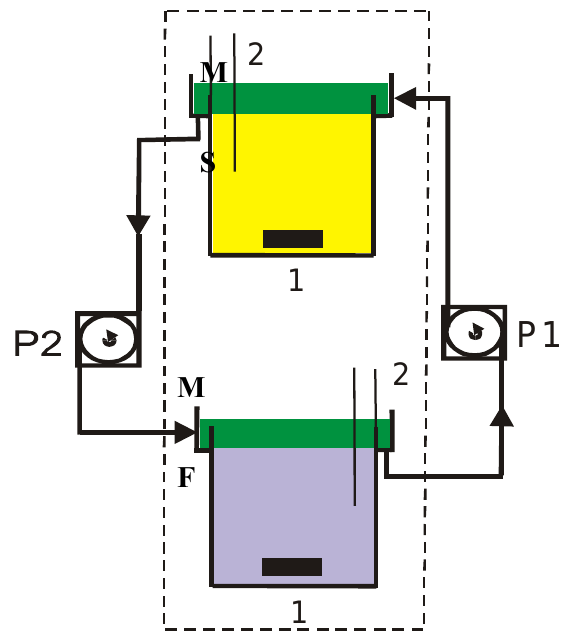
Figure 1. Scheme of the measuring set with flows bulk liquid membrane. 1 – magnetic stirrers, 2 -sampling. M – membrane, F – feed phase, S – stripping phase, P1, P2